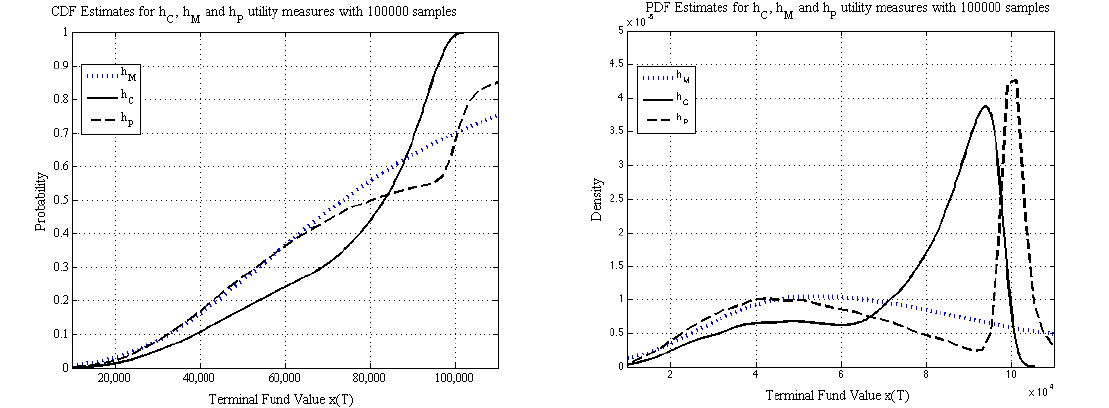
Figure 4. Fund value cumulative and probability